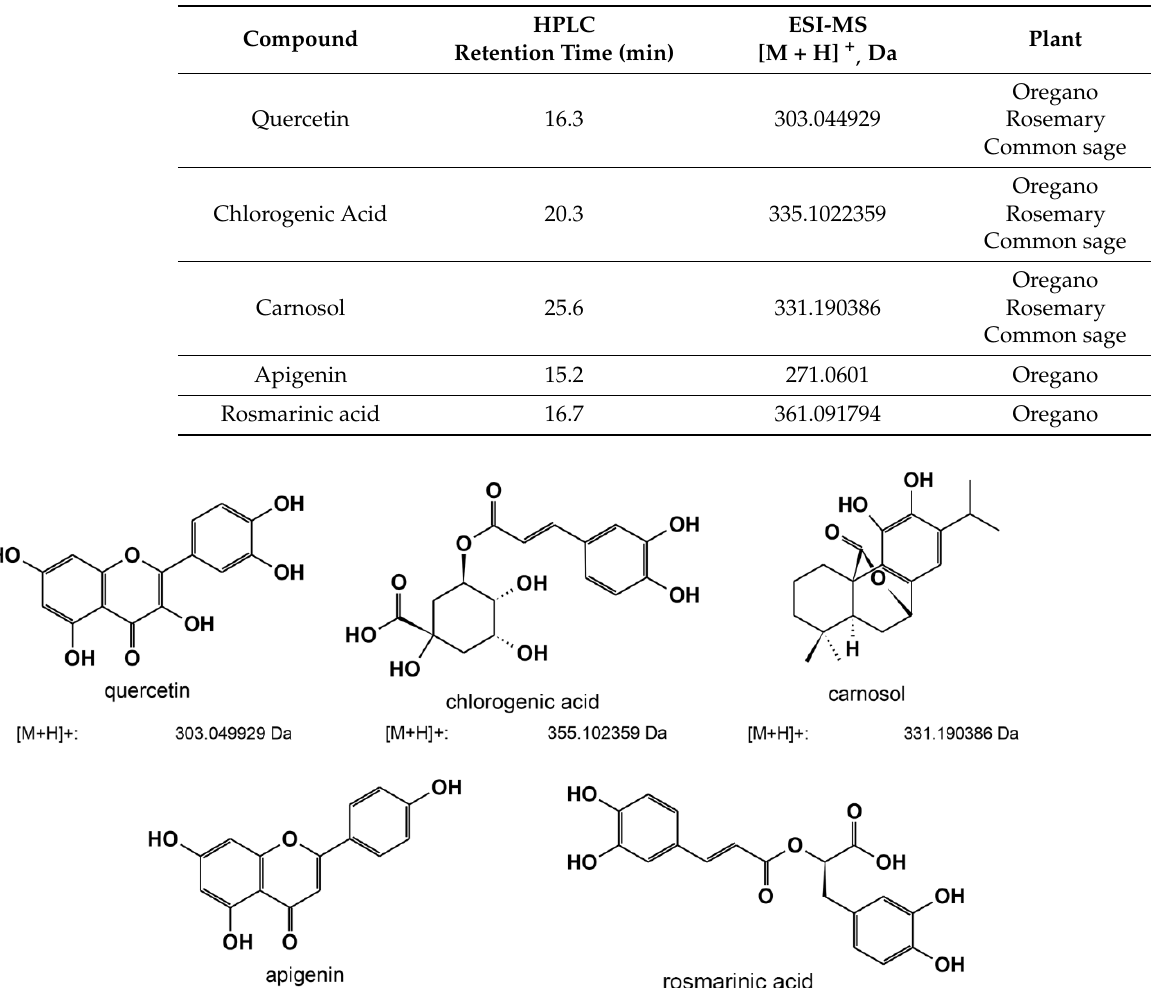
Table 2. Composition of ethanolic extracts of oregano, rosemary, and common sage as assessed by HPLC and ESI-MS.